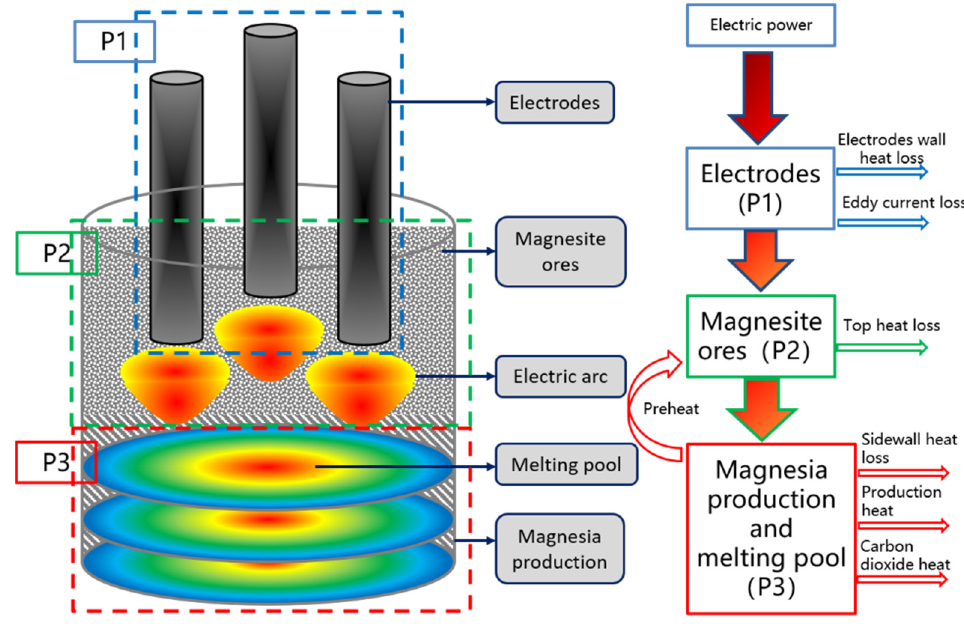
Figure 1. Schematic diagram of the fused magnesia furnace. Table 1. Furnace